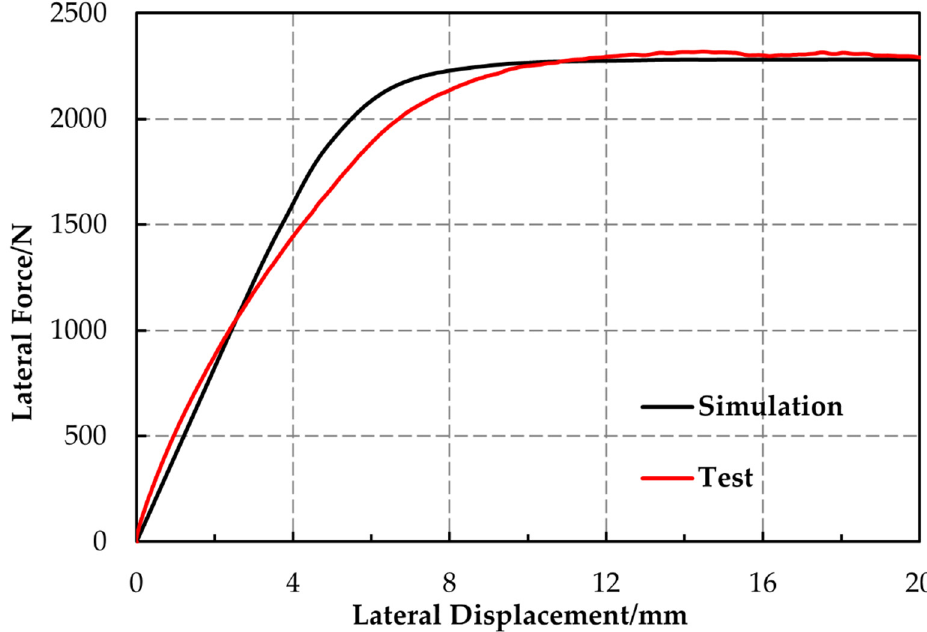
Figure 7. The courses of the center lines of the lateral stiffness in the test and simulation.